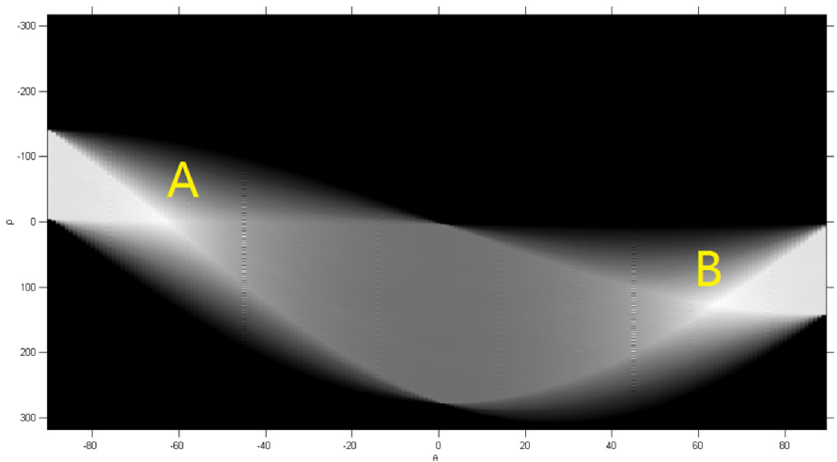
Figure 11. Hough line detection.